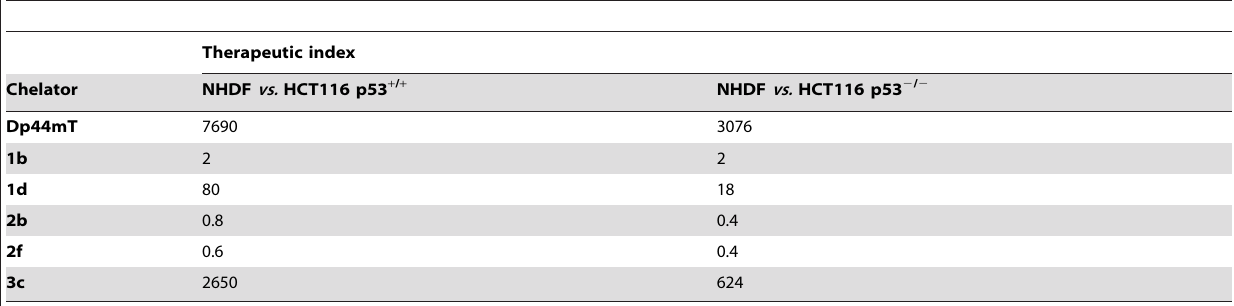
Table 2. The selectivity of Dp44mT relative to the 5 most potent anti-cancer TSCs, namely 1b , 1d , 2b , 2f and 3c , was examined by calculating their ‘‘therapeutic